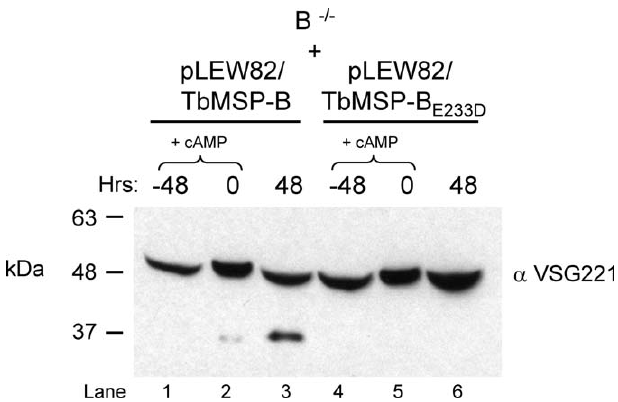
Figure 10. Truncated VSG221 Protein Occurs in the Culture Medium of Differentiating B (cid:2) / (cid:2) Cells When Complemented with TbMSP-B (Lanes 1– 3) but Not When Complemented with TbMSP-B E233D (Lanes 4–6) Aliquots of the culture medium were collected as previously described and probed in a western blot with antiserum directed against VSG221 ( a VSG221).